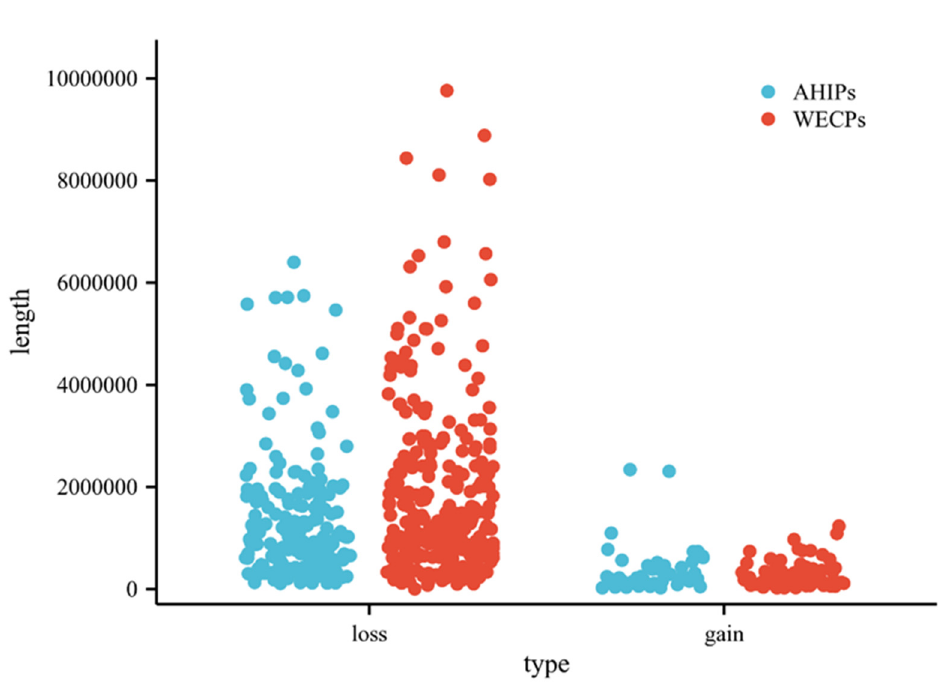
Figure 2. Genomic distribution and status of CNVRs in pig autosomes. The locations of 604 CNVRs are shown on the autosomes in blue (AHIPs_loss), yellow (AHIPs_gain), red (WECPs_loss), and green (WECPs_gain). Y-axis values are chromosome names, and X-axis values are chromosome po- sition in Mb, which are based on the Sscrofa 10.2 reference genome assembly.